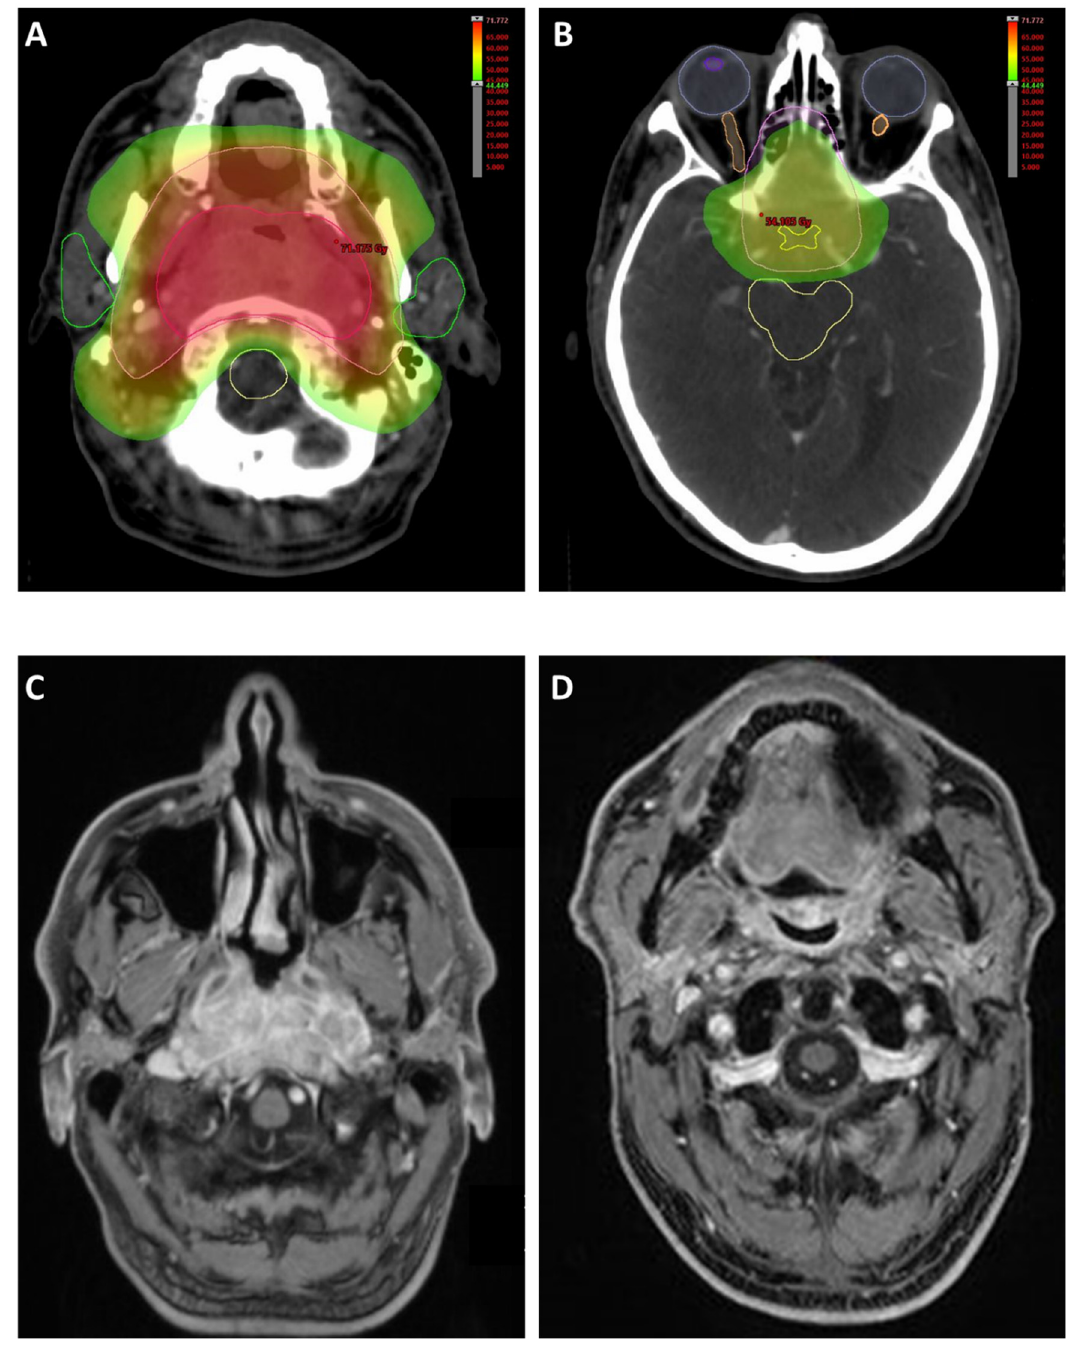
Figure 5. 67-year-old male patient with an EBV-positive nasopharyngeal squamous cell carcinoma, infiltrating the sella turcica, clivus and right-sided internal carotid artery and affecting the chiasma, cT4 cN0 cM0, G3. Definitive cisplatin- based chemoradiotherapy was applied between May and July 2018. The primary tumor received 69.4 Gy in 37 fractions (14 fractions with 2 Gy and 23 fractions with 1.8 Gy). ( A , B ) Axial images showing bilateral parotid gland and spinal cord protection. ( C ) Contrast-enhanced MRI showing the nasopharyngeal carcinoma prior to radiotherapy. ( D ) Follow-up image at 2.5 years later (September 2020) showing no signs of recurrence.